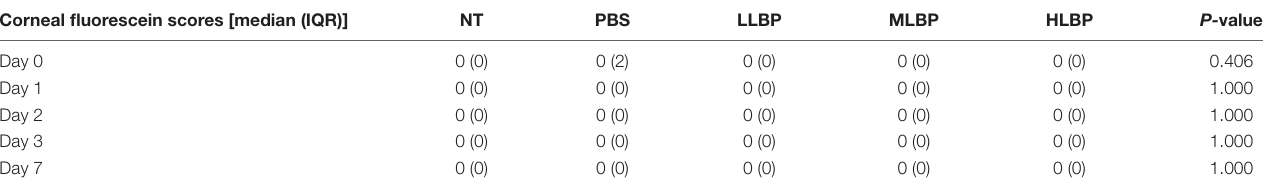
TABLE 3 | The results of corneal fluorescein staining scores in the safety test. Corneal fluorescein scores [median